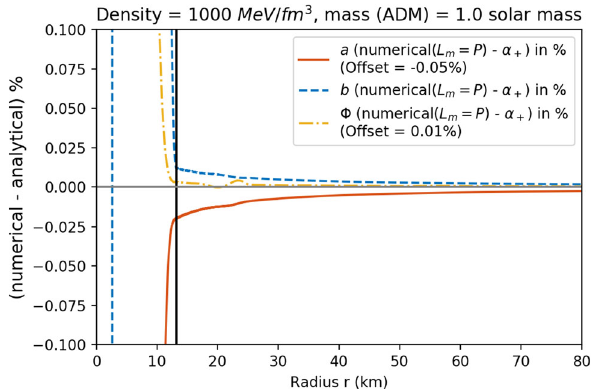
Fig. 5 % difference of the metric components and the scalar field between the analytical solution α + and the numerical solution for = P , for ρ = 1000 MeV / f m 3 . The vertical line indicates the L m 0 radius of the compact object